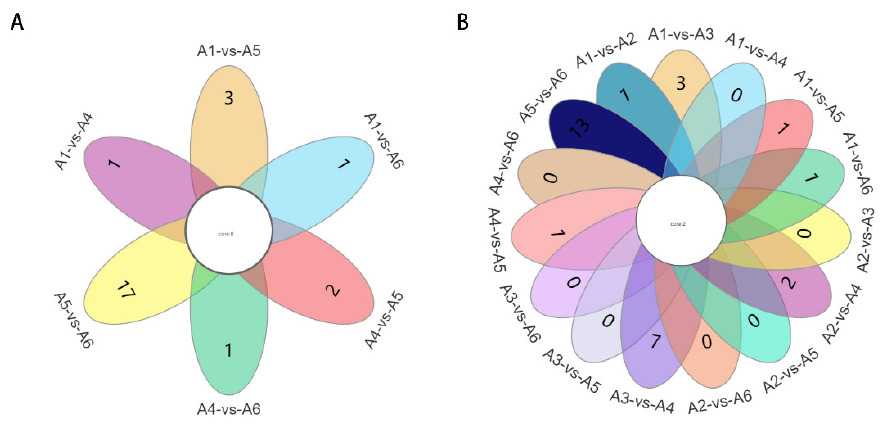
Figure 5. Paired comparison plots of differential metabolites ( A ) Venn diagram of differential metabolites for each comparison group of A1, A2, A3, A4, A5, and A6. ( B ) Venn diagram of differential metabolites for each comparison group of A1, A4, A5, and A6.